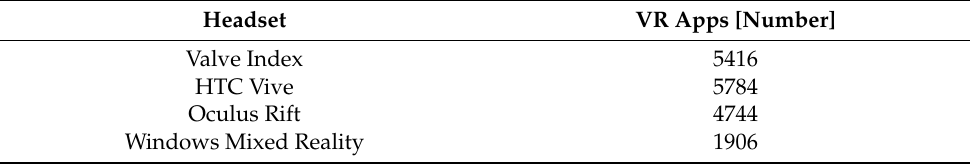
Table 2. The number of VR applications based on the number of players [state on 6 July 2022]. Number of Players VR Apps [Number] Singleplayer 6058 Multiplayer 1320 PvP 946 Online PvP 853 LAN PvP 52 Shared/Split Screen PvP